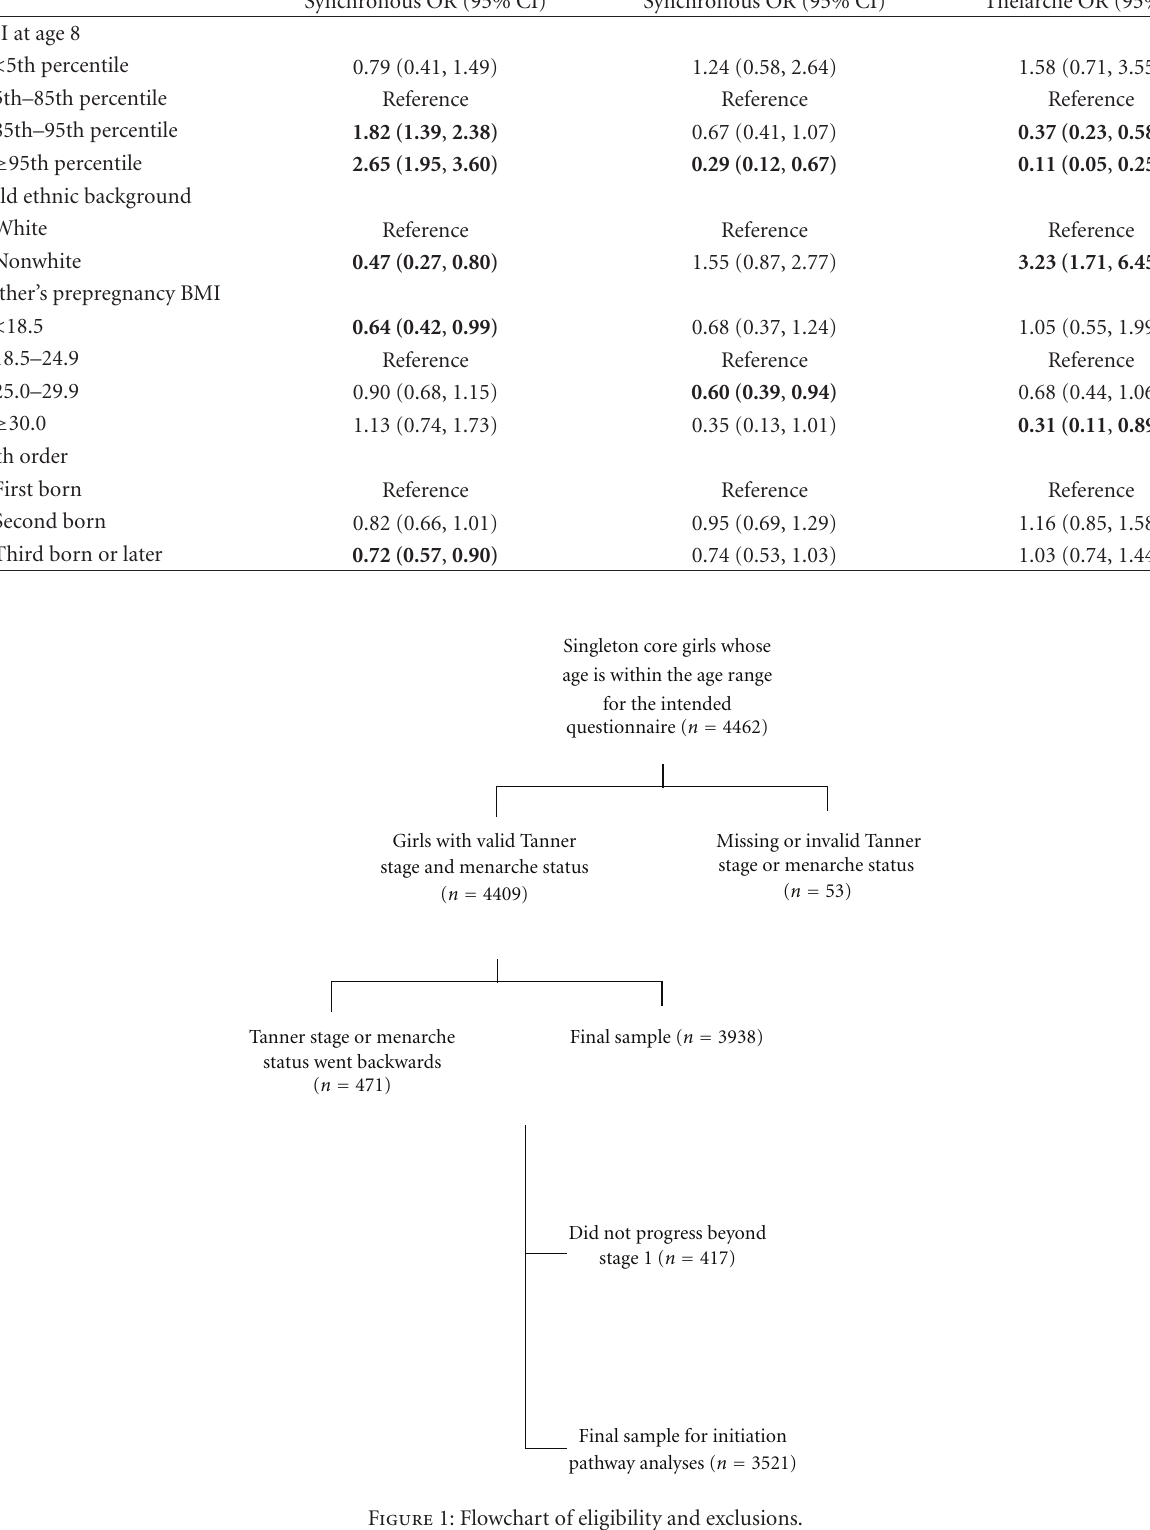
Figure 1: Flowchart of eligibility and